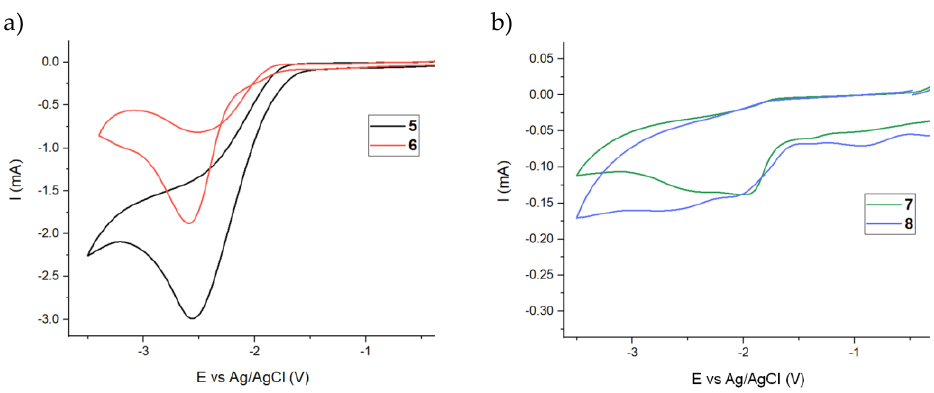
Figure 6. ( a ) Cyclic voltammetries of BDILs 5 and 6 0.01 M in MeCN at 100 mV s − 1 ; ( b ) cyclic voltammetries of BDILs 7 and 8 0.01 M in MeCN at 100 mV s − 1 .